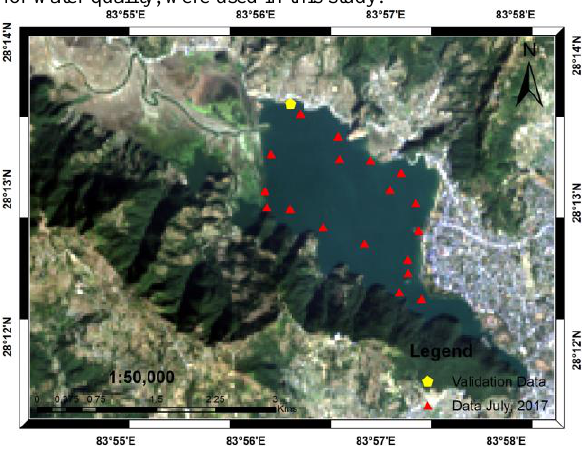
Figure 2. Location map of the study area